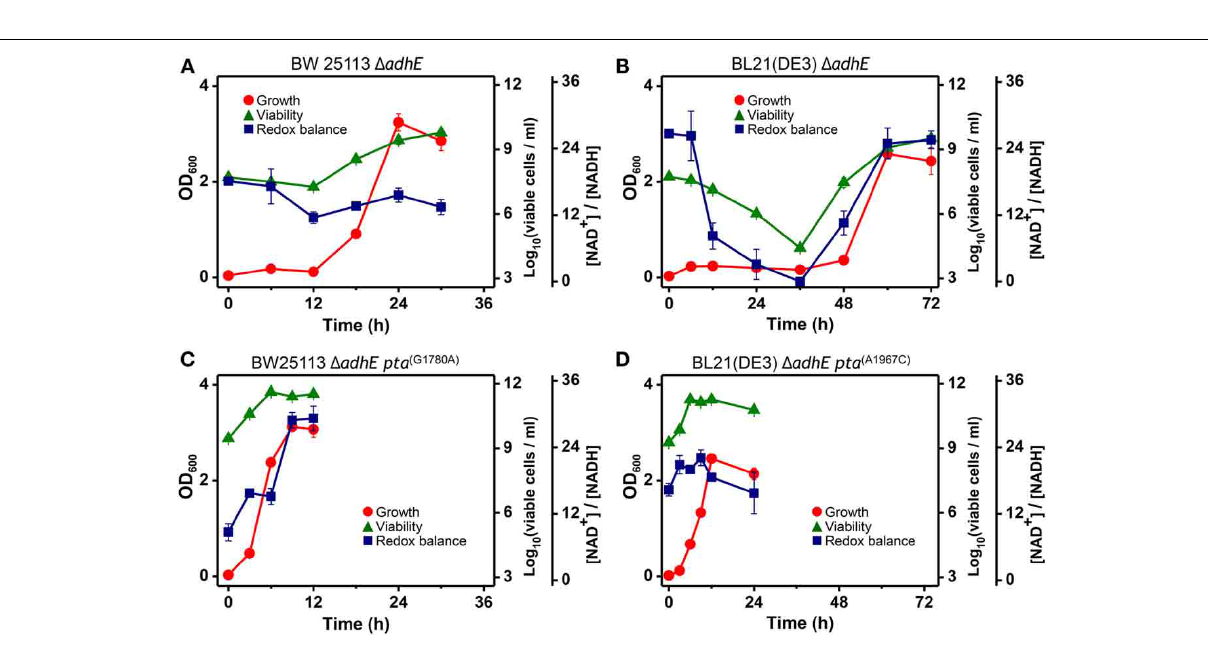
FIGURE 10 | Analysis of intracellular redox balance and viability of anaerobically grown cells of BW25113 (cid:2) adhE (A), BL21(DE3) (cid:2) adhE (B), adapted BW25113 (cid:2) adhE pta (G1780A) (C), and adapted BL21(DE3) (cid:2) adhE pta (A1967C) (D).